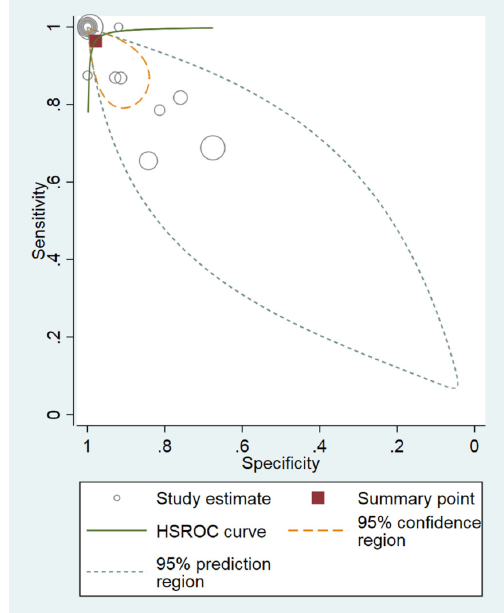
Figure 4. Hierarchical summary receiver operating characteristic (HSROC) curve of the diagnostic performance of the MRPI for the differentiation of progressive supranuclear palsy from Parkinson’s disease. A significant difference was observed between the 95% prediction region and the 95% confidence region, indicating a high possibility of heterogeneity. MRPI, magnetic resonance parkinsonism index.